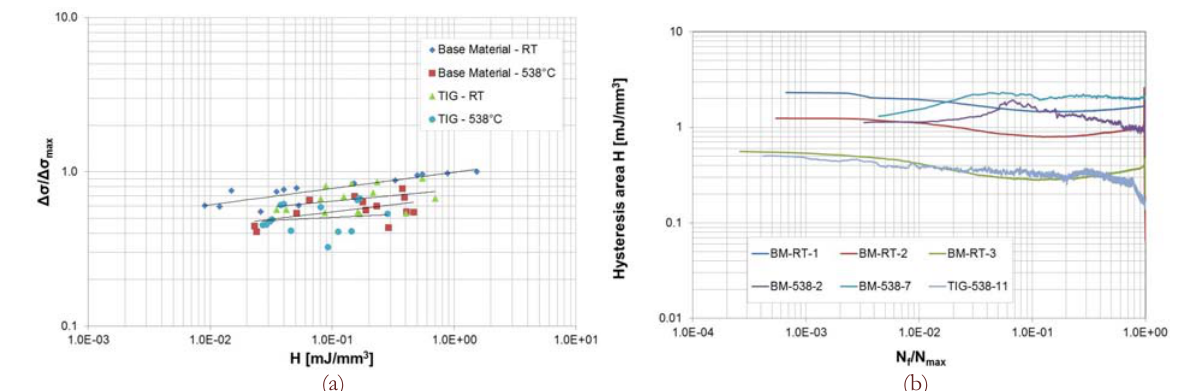
Figure 3: Correlation between resulting stress range and hysteresis area (a) and hysteresis area trend against fatigue life (b).